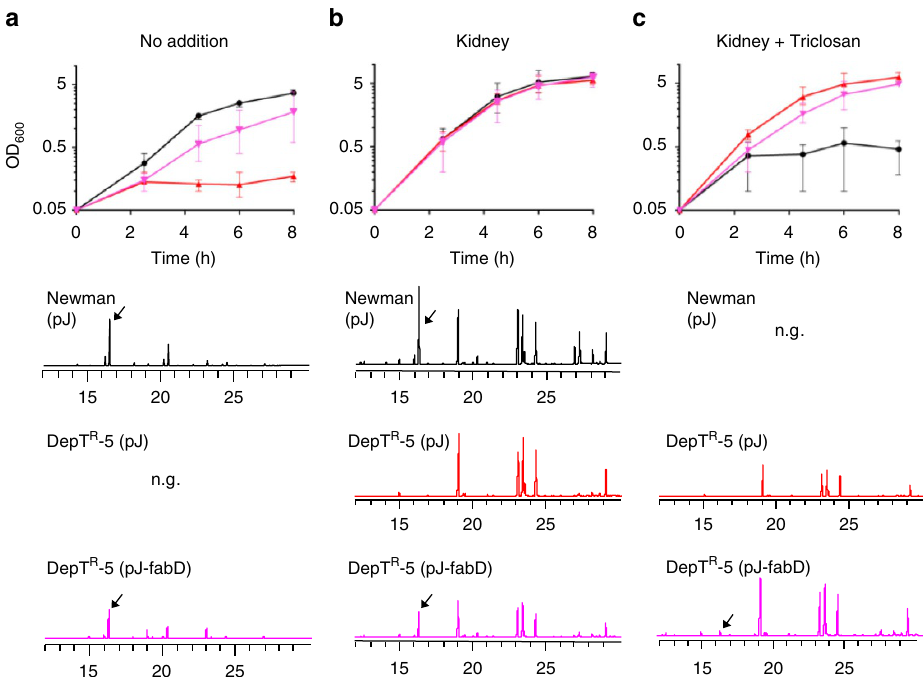
Figure 4 | Complementation of DepT R -5 by the wild type fabD allele. Overnight LB-FA cultures of WTand DepT R -5 strains carrying pJ (control plasmid), or pJ-fabD (expressing the fabD gene) were washed twice in LB, and cultures were inoculated at a starting OD 600 ¼ 0.05 in ( a ) LB (Cm 3 m gml (cid:2) 1 and ATc 50ngml (cid:2) 1 ), ( b ) the same medium containing sterile-filtered pig kidney extract (3% final volume) without or ( c ) with triclosan (0.5 m gml (cid:2) 1 ). OD 600 was followed over 8h. Fatty acid profiles were determined from harvested cells, as shown below the corresponding growth condition. N.g., no growth. Reference fatty acid profile and peak identification of kidney extract is in Supplementary Fig. 4. Growth results show the average with standard deviation of three experiments that gave comparable results (Supplementary Fig. 5). However, despite precautions, growth was variable between independent experiments, which may be due to the counter-selective effect of triclosan on the pJ-fabD plasmid.